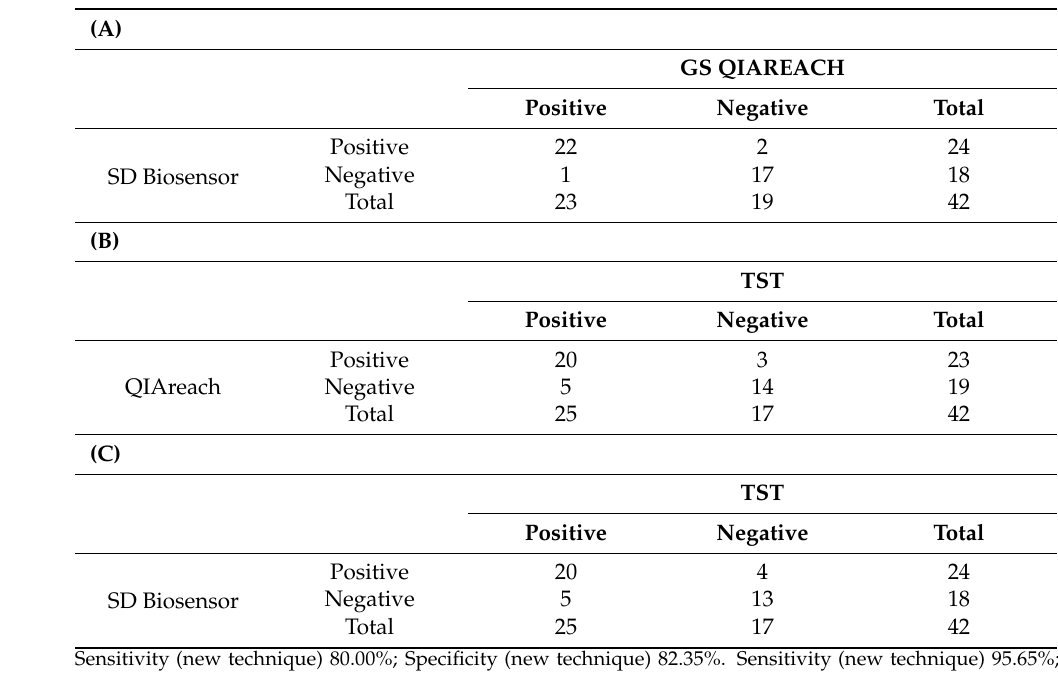
Table 4. (A). Comparison between the new IGRA technique and the Gold standard. Samples collected from HBLT patients ≥ 36 years of age, (September to December 2022) ( n = 42). (B). Comparison between QIAreach and TST. Samples collected from HBLT patients > = 36 year of age (September to December 2022) ( n = 42). (C). Comparison between the new IGRA technique (SD BIOSENSOR) and